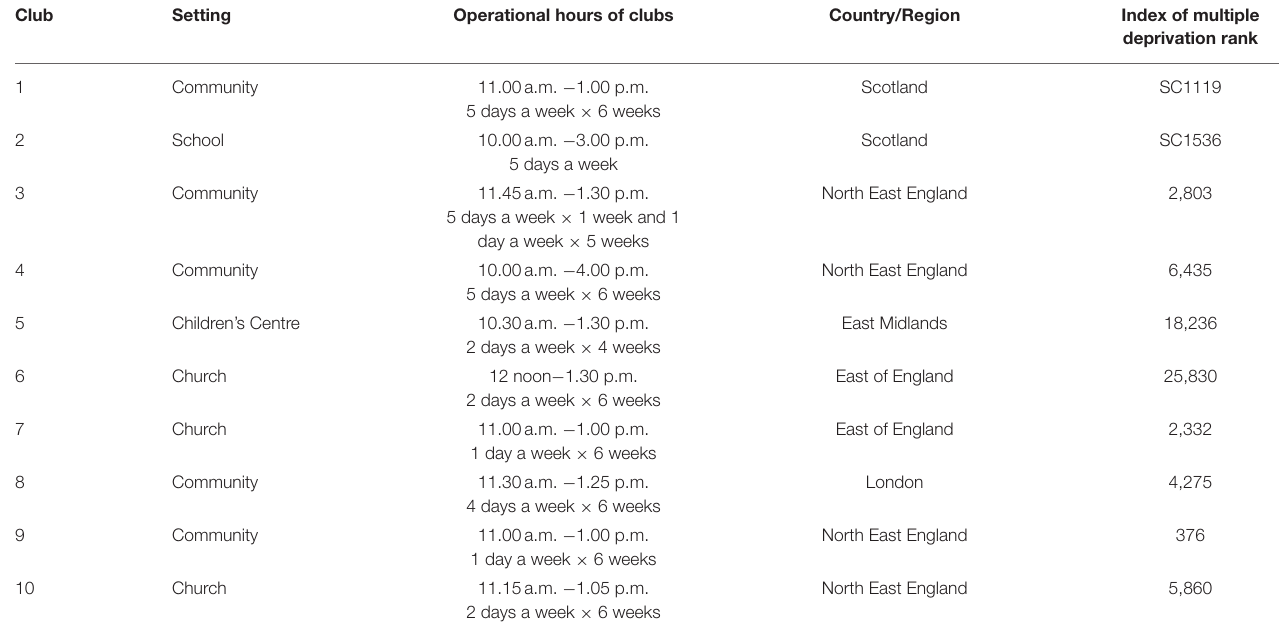
TABLE 2 | Holiday club characteristics.